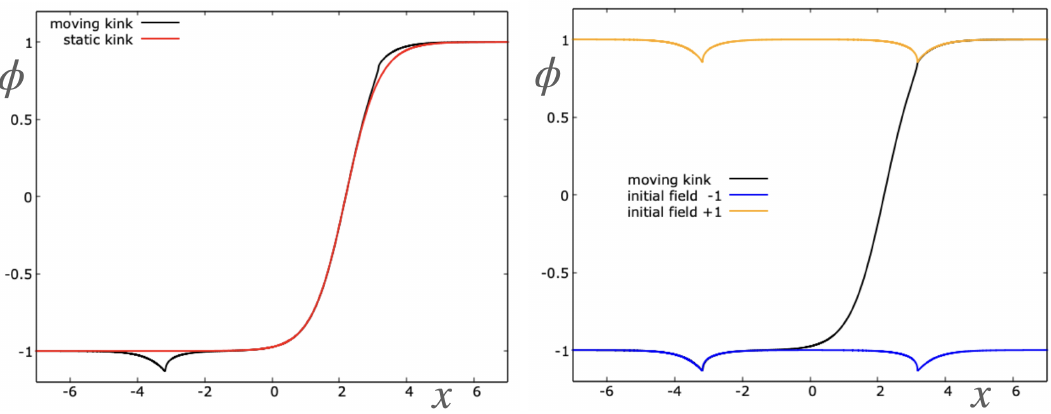
Figure 2 . Left: the moving kink (black curve) at t = 200 and the static kink (red curve) with the same position. Right: the moving kink (black curve) at t = 200 . The field at t = 200 from the initial condition φ = − 1 (blue curve) and φ = 1 (orange curve) with the initial time derivative ˙ φ the same as for the moving